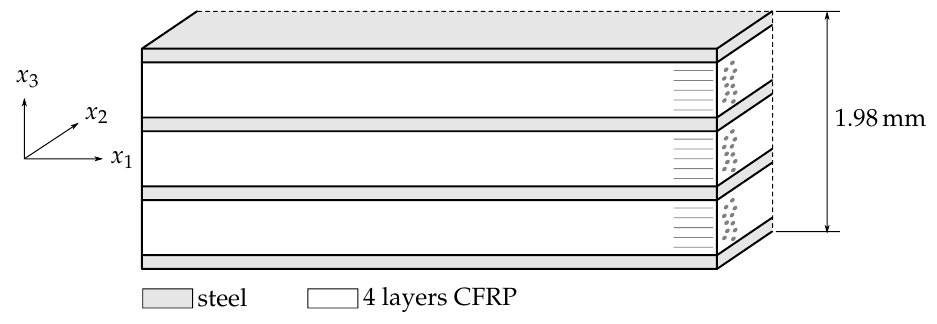
Figure 1. Material layout of the FML